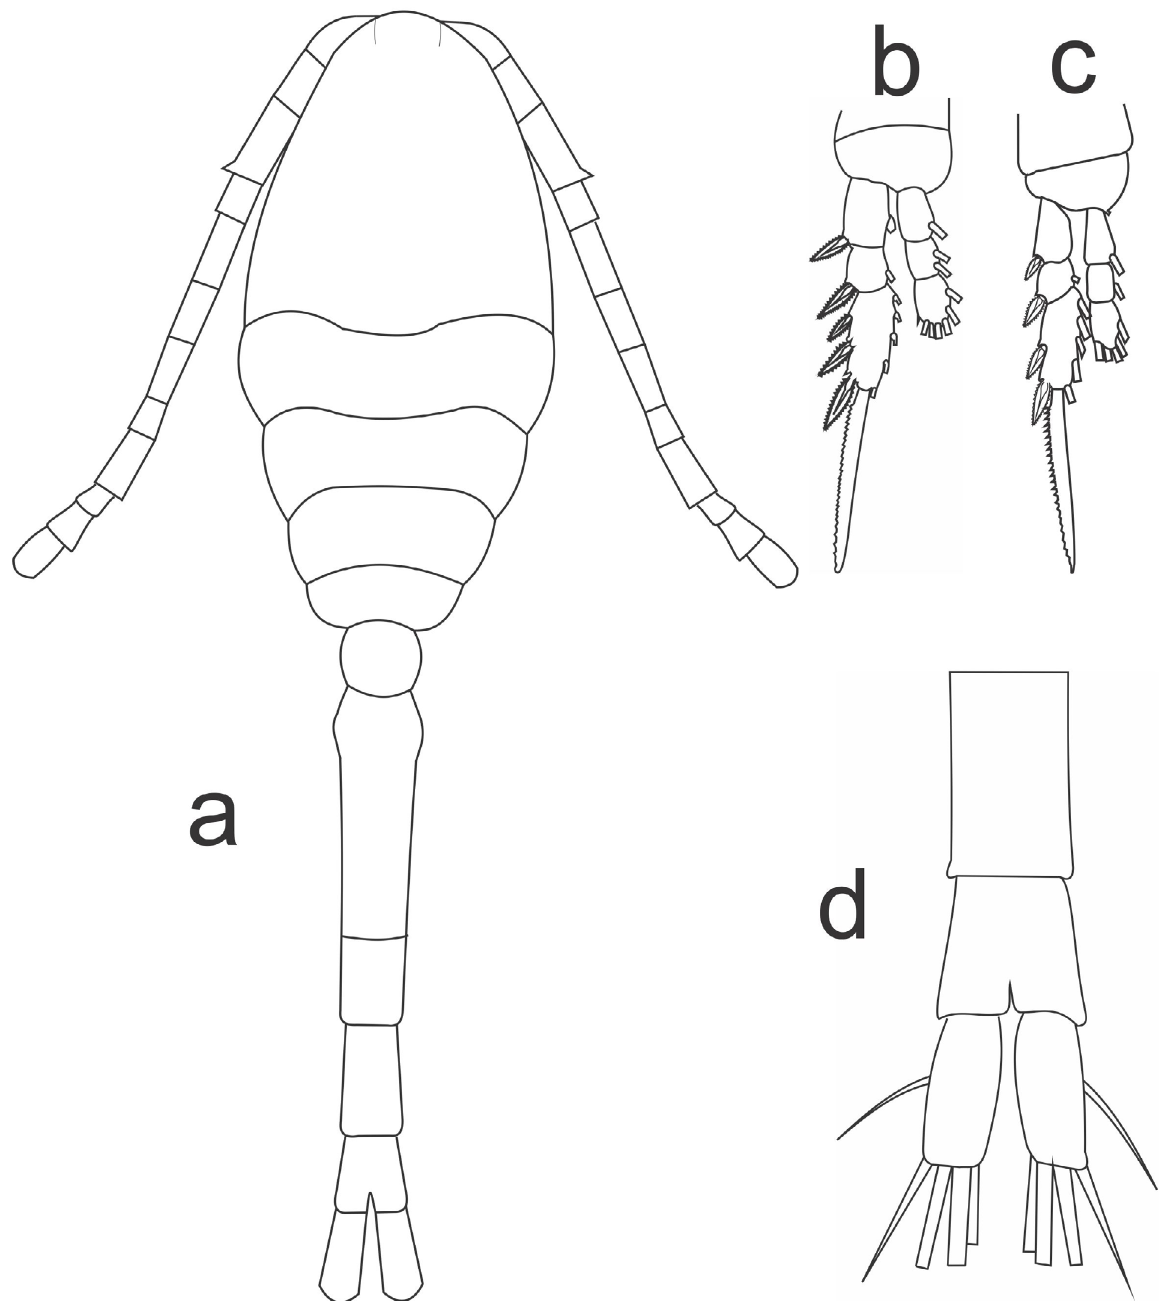
Figure 2. Oithona attenuata Farran, 1913. a, Whole body, dorsal view; b, leg 3; c, leg 4; d,